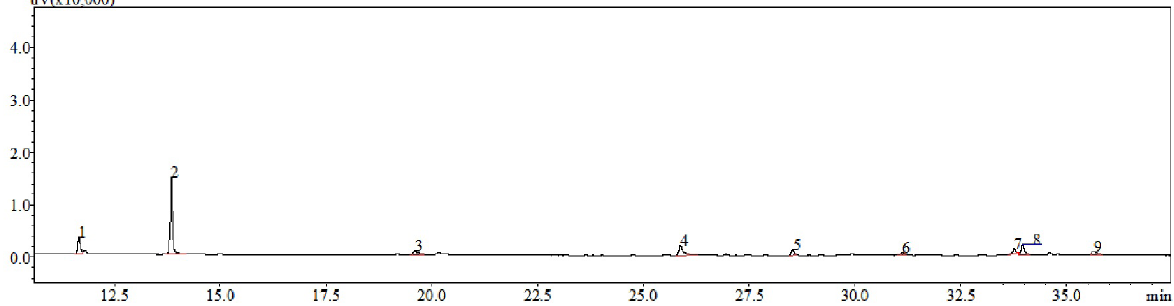
Figure 1. Chromatogram (CG-DIC) of essential oil from leaves of Vitex agnus-castus.